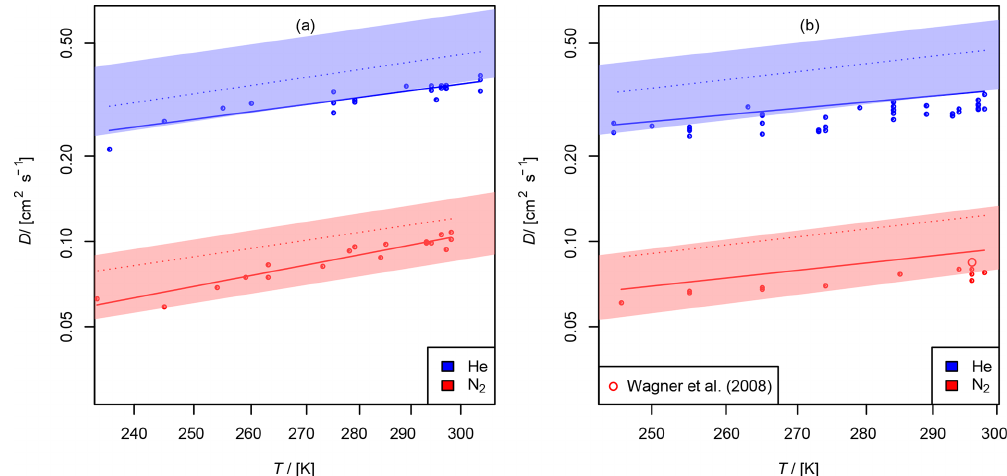
Figure 11. (a) Diffusion coefficient of chlorine nitrate in helium and nitrogen; (b) diffusion coefficient of dinitrogen pentoxide in helium and nitrogen as a function of temperature. The experimental result of 0.085cm 2 s − 1 from Wagner et al. (2008) is displayed for comparison. The shaded areas show the diffusion coefficients expected by the Lennard–Jones model. The dotted lines are calculated by Fuller’s model. The solid lines displayed for N 2 O 5 are calculated using Eq. (15) extrapolating to k 1 = 0s − 1